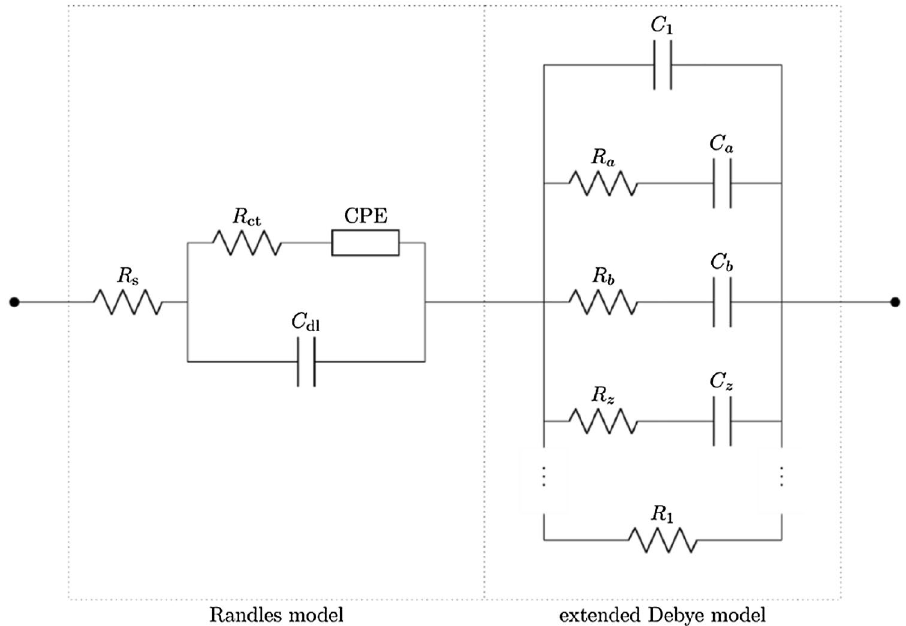
Figure 1. The unified equivalent circuit model of the cell-line suspension, and in the extended Debye model section 33 .